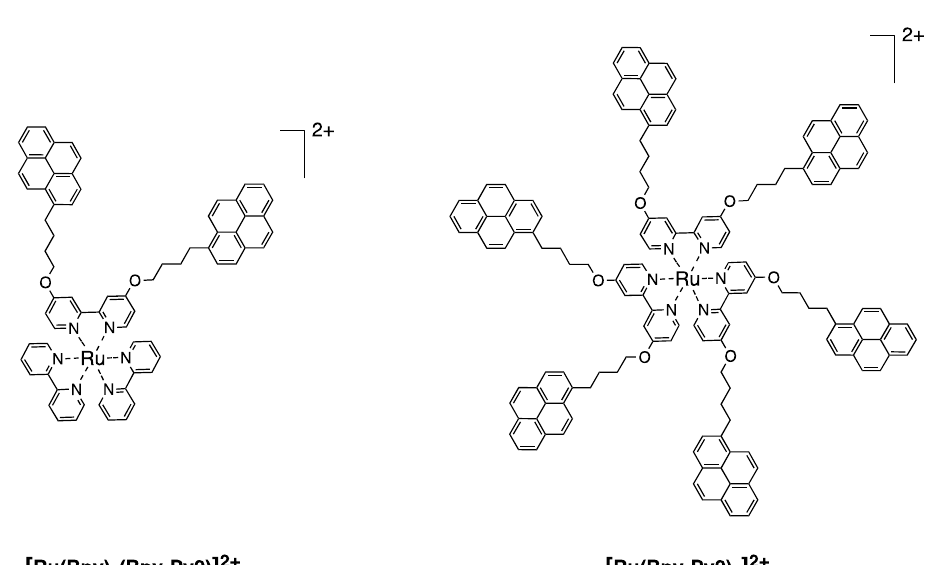
Figure 10. Structures of the ruthenium bipyridine complexes containing two and six pyrene units [49].